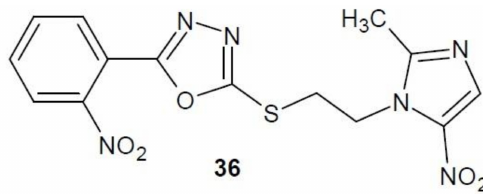
Figure 14. 1,3,4-Oxadiazole derivative with activity of thymidylate synthase